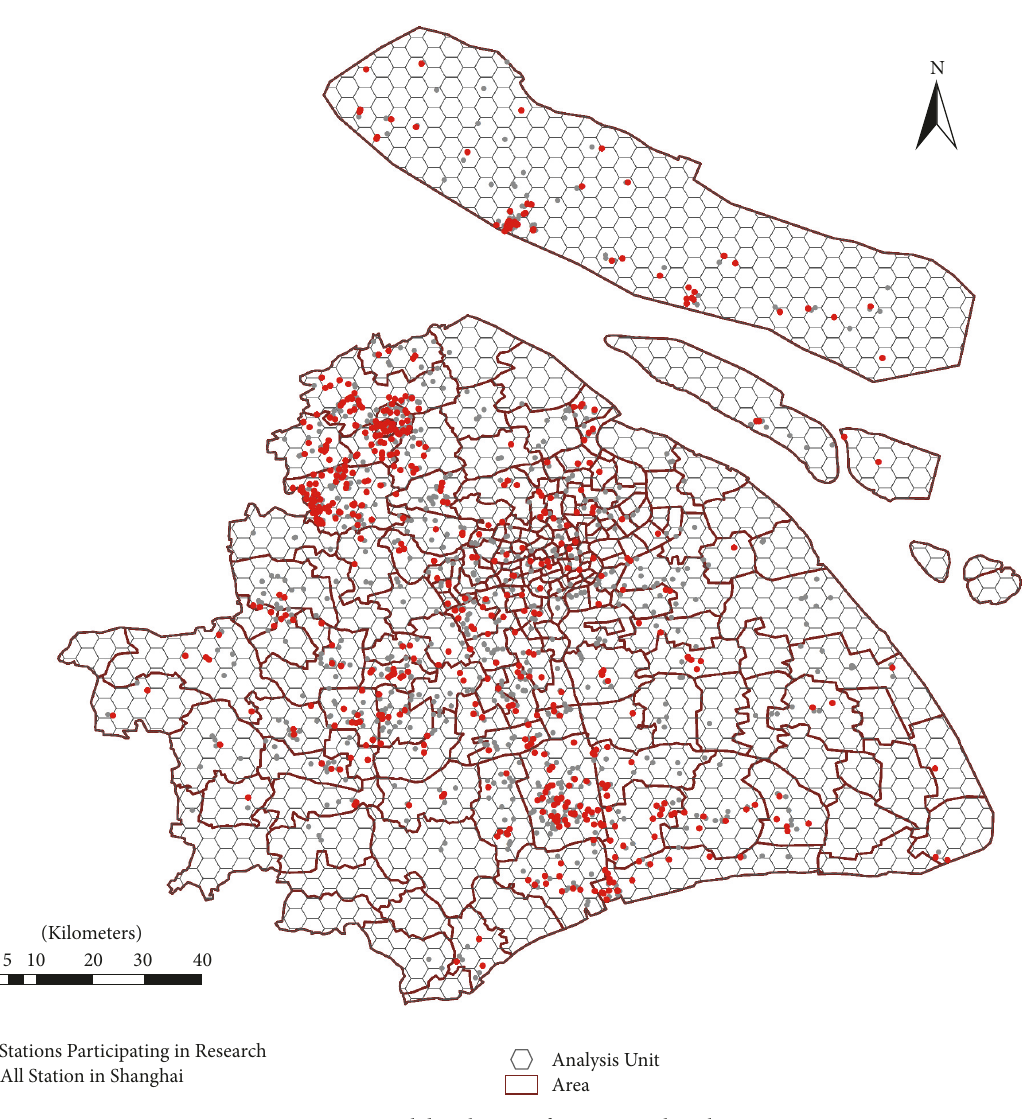
Figure 1: Spatial distribution of stations in Shanghai.